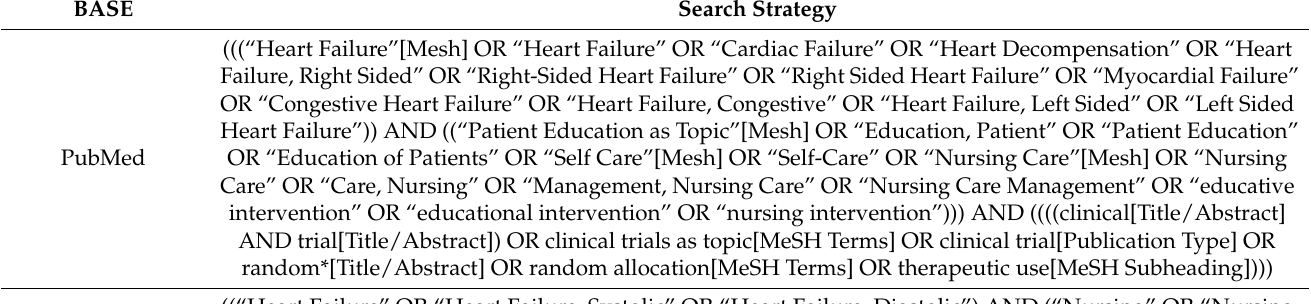
Table A1. Search strategy used in PubMed, SciELO, CINAHL, Cochrane, Google Scholar, Clinical Trials, and OpenThesis